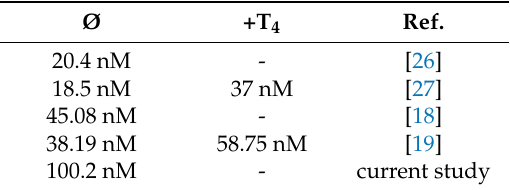
Table 4. CPA concentrations equieffective with the surplus interstitial adenosine accumulated in solely NBTI-treated eu- and hyperthyroid guinea pig atria, determined with